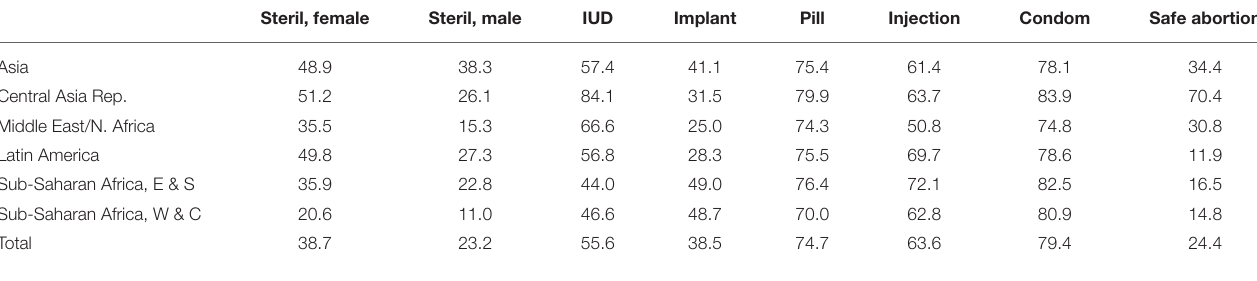
TABLE 3 | Percent with access to each